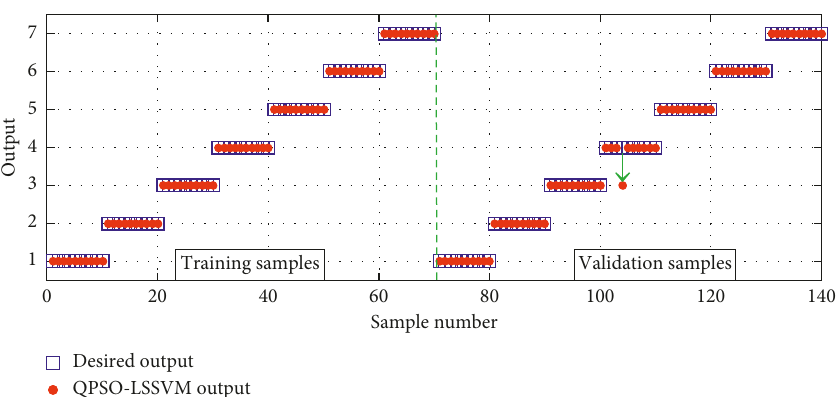
Figure 13: Classification results of the PSO-LSSVM model based on ASD and MFDFA parameters.